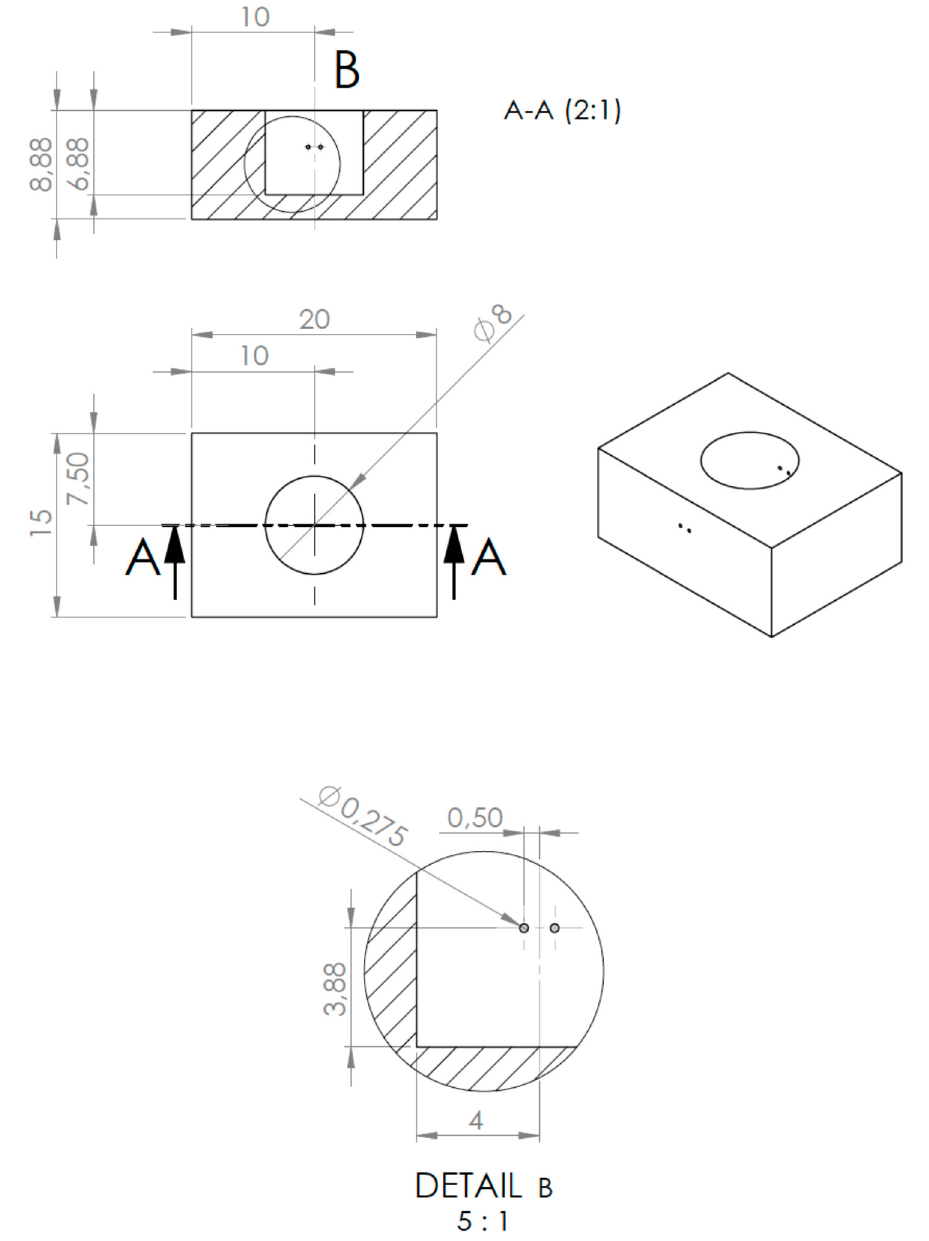
Figure A1. The drawings of the fully assembled cartridge utilized by the MICELI system with geometric dimensions of the cartridge, reaction well, and electrode channels.